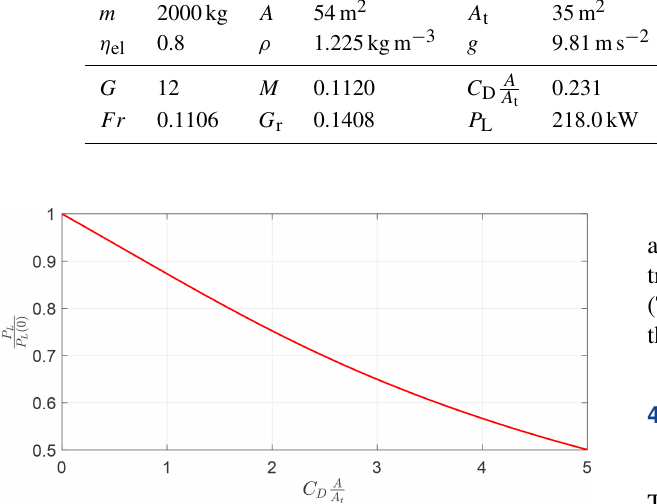
as a function = 0) P L ( C D A A t